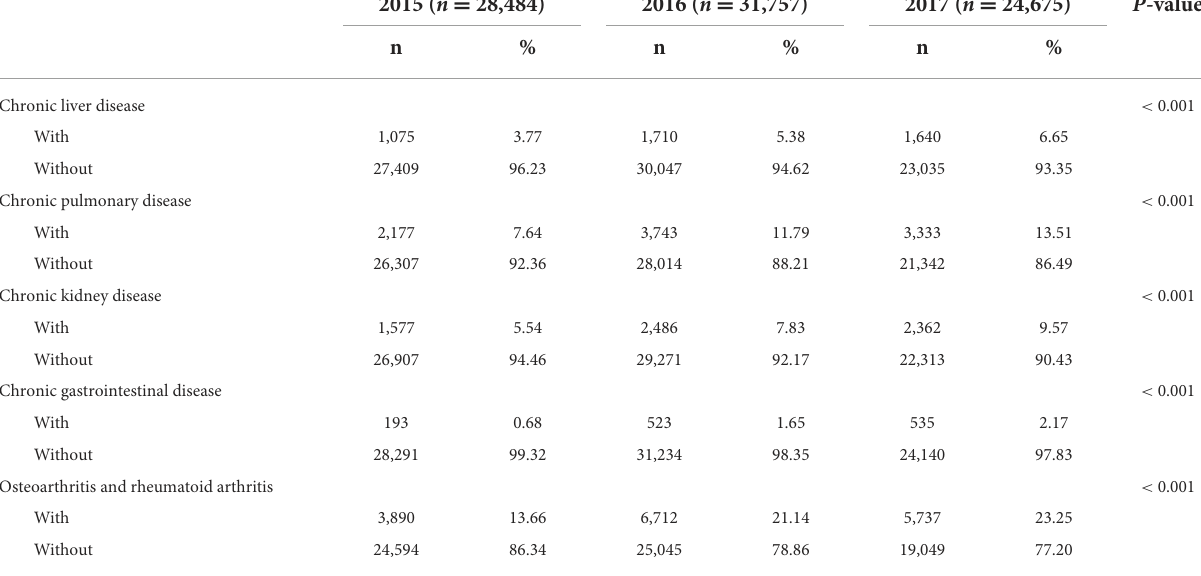
(Table 2, Supplementary Tables 4, 5). The prevalence of polypharmacy was associated with female sex (Table 2). Finally, on adjusted logistic analysis, the probability of